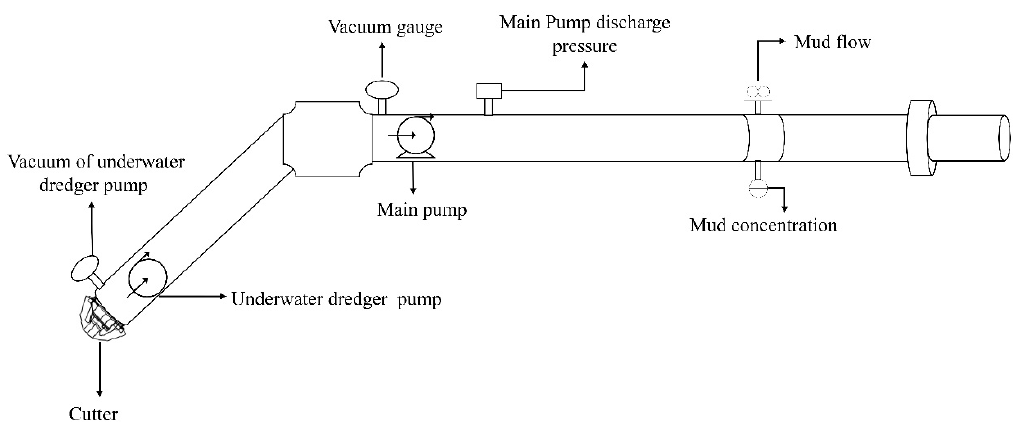
Figure 1. Main testing equipment of the mud pipeline transportation system.